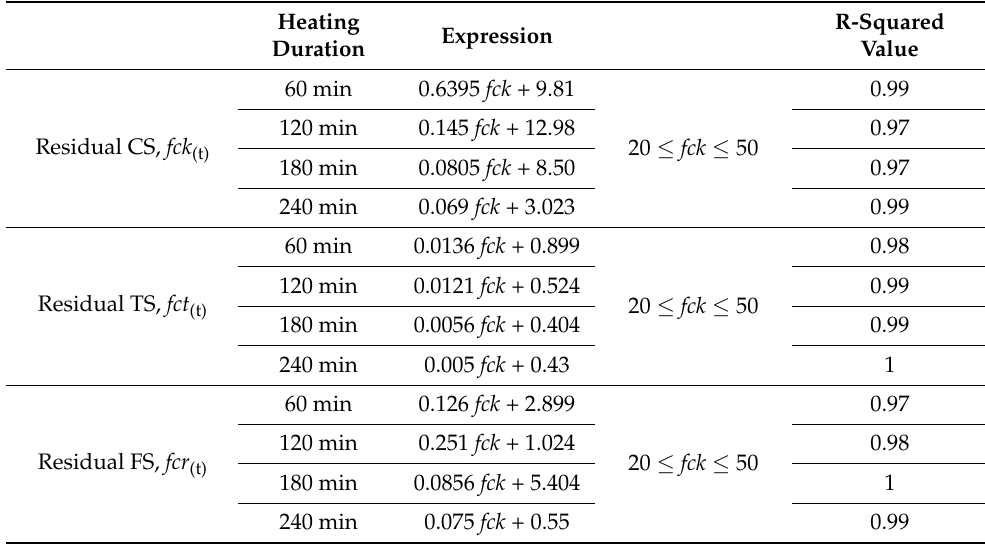
Table 3. Empirical relations used to estimate the residual strength of